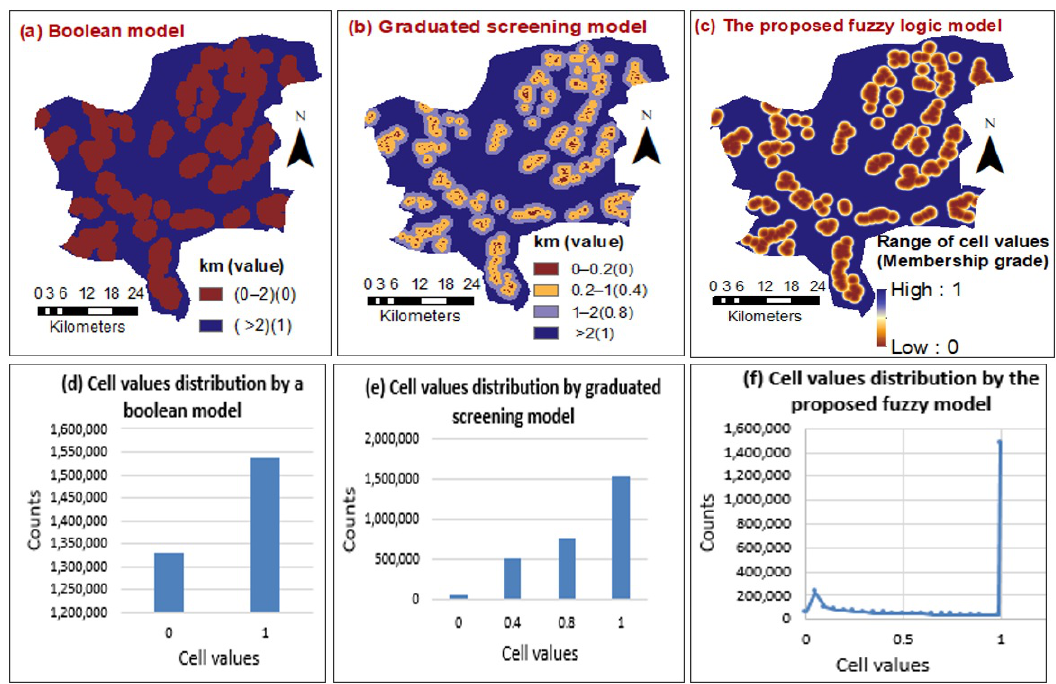
Figure 7. Map standardization models: ( a , d ) Boolean logic; ( b , e ) graduated screening model; ( c , f ) modified fuzzy membership